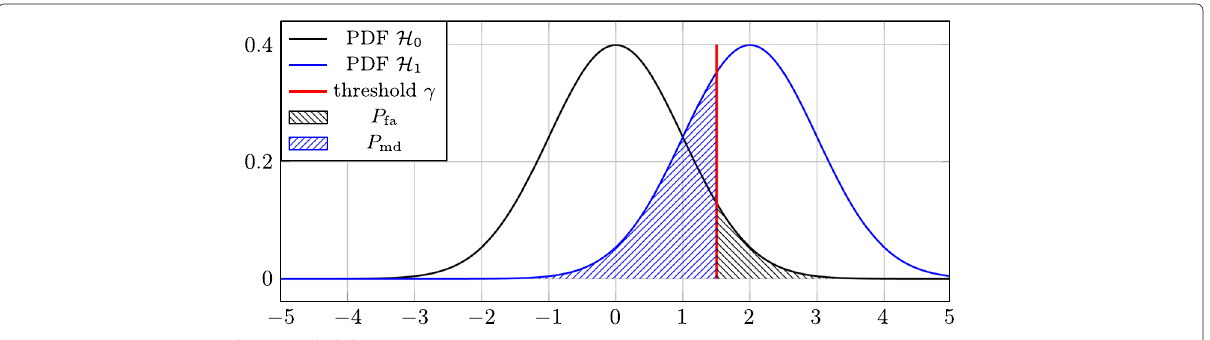
Fig. 1 Test statistic PDFs and error